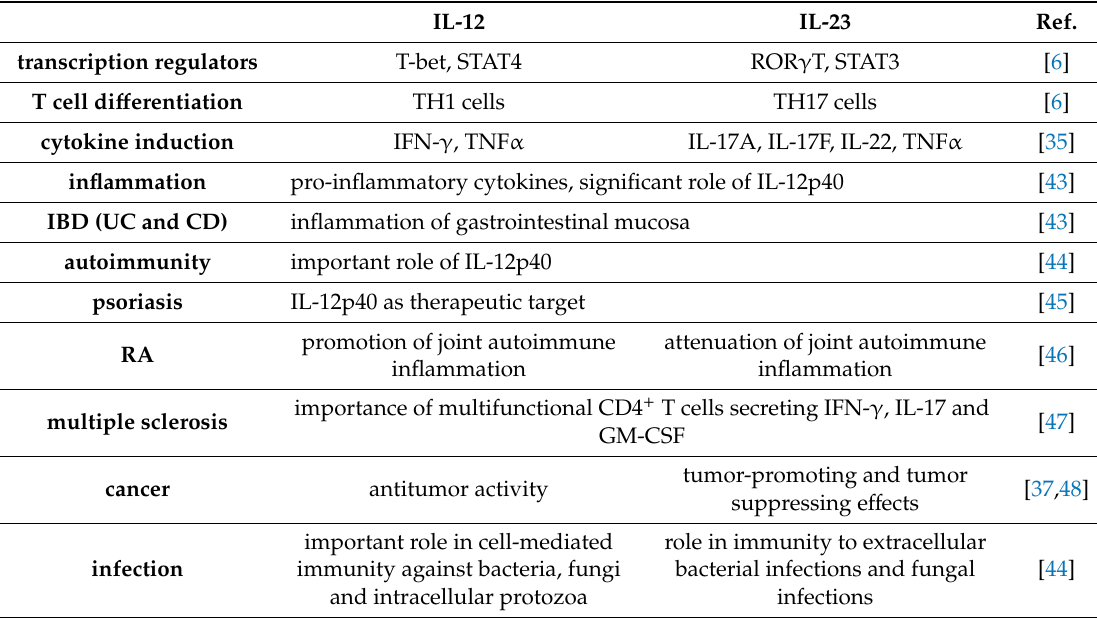
Table 2. Similarities and Di ff erences of IL-12 and IL-23 on Immune Response. IL-12 IL-23